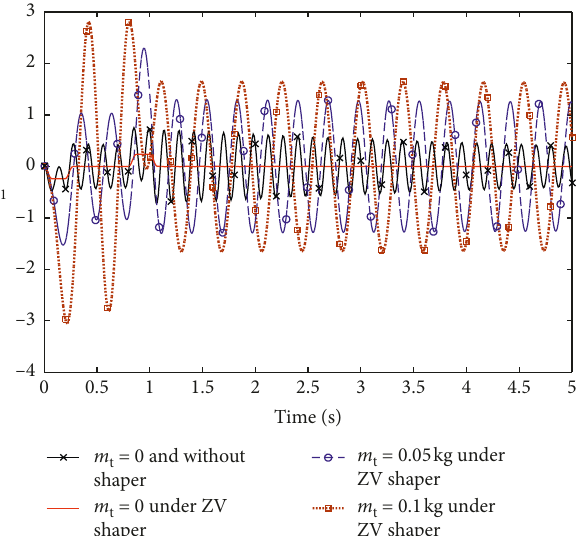
Figure 9: Control effects of the ZV input shaper on the first-order mode of the flexible manipulator under different terminal load conditions.